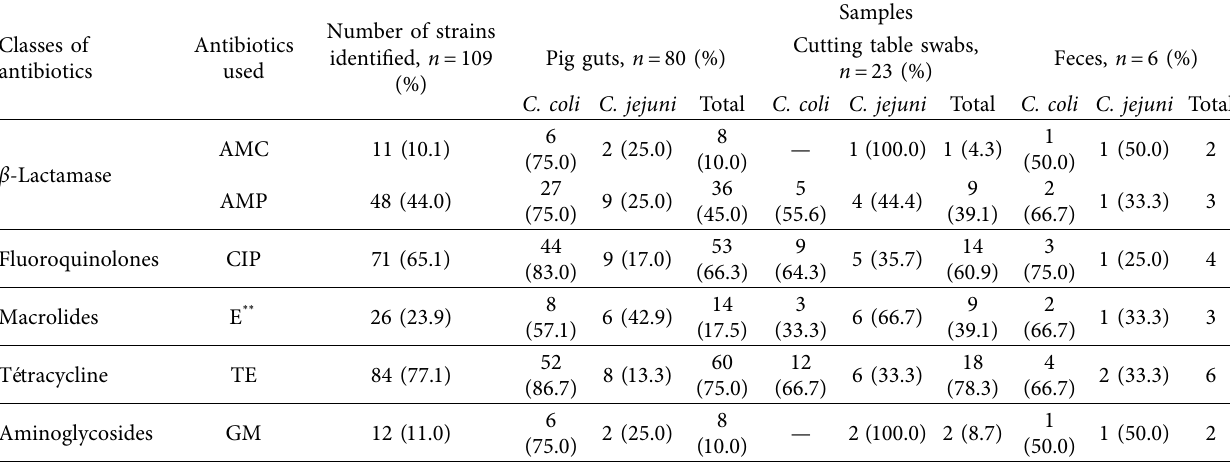
Table 5: Percentages of resistance of C. coli and C. jejuni strains to antibiotics according to